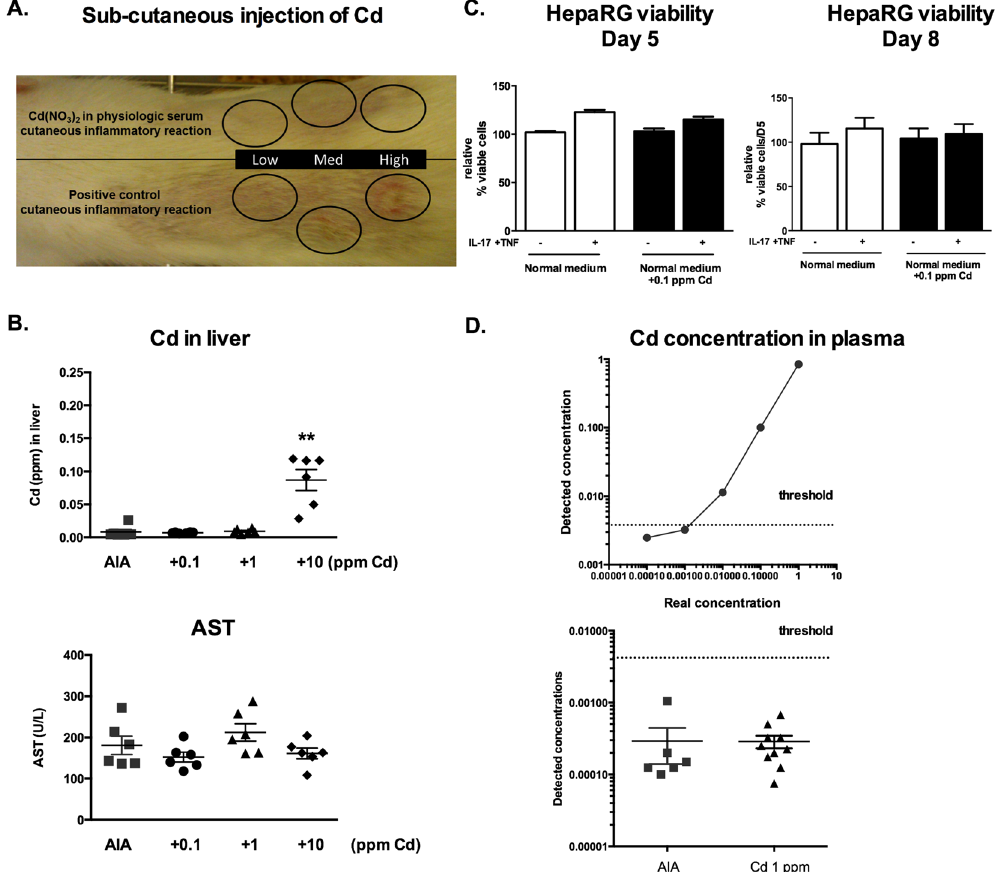
Figure 5. Cadmium spread in tissues and organs from the joint is limited and not harmful. ( A ) Subcutaneous injection of Cd and positive inflammatory control at increasing concentrations. ( B ) Measures of Cd and AST concentrations in liver tissue taken at necropsy on day 23. ( C ) Hepatocyte cell viability measured by neutral read assay after 5 and 8 days of exposure to Cd. ( D ) Plasma Cd concentration. On the upper panel known concentrations of Cd were measured to define the detection limit threshold. On the lower panel Cd concentration detected in plasma of 1 ppm treated rats. Dashed line represent detection limit threshold. Results represent independent measures on at least 5 animals per group. Data are represented as mean ± SEM; ** p <